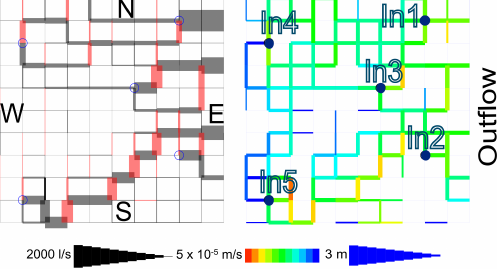
Figure 14. Distribution of flow between two pathways depends on the flow resistance when the flow is pressurized. The pathway a has with lower flow resistance grows faster. After the transition to free- surface flow, the pathway b with higher exit slope from the junction can capture more flow and incise faster.